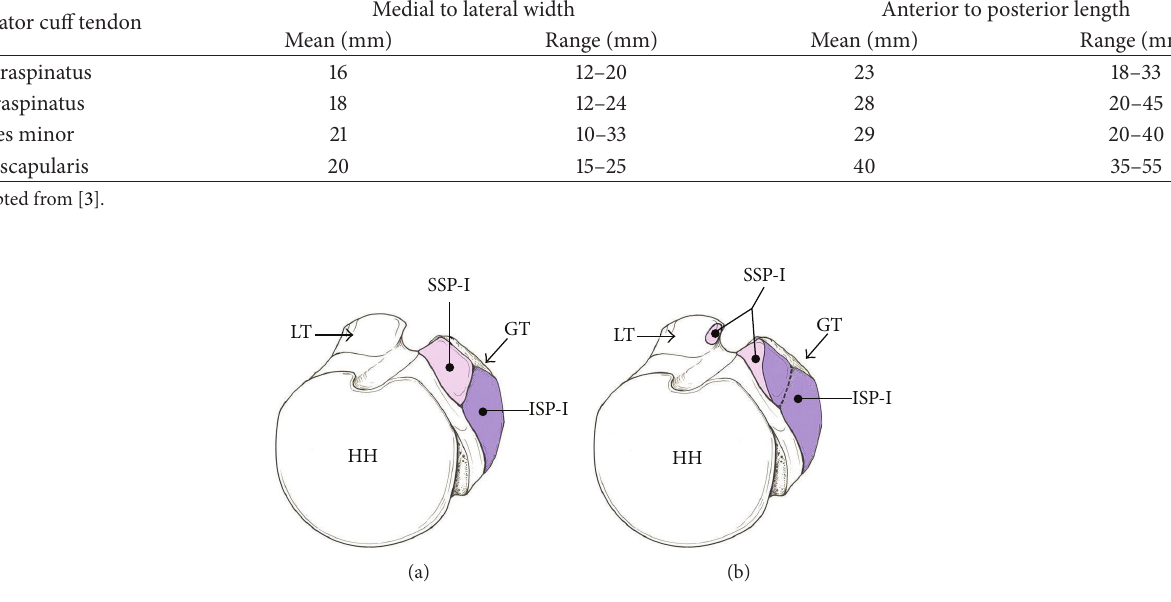
Figure 1: Illustration showing the two different insertional descriptions of the humeral insertions of the supraspinatus (SSP-I) and infraspinatus (ISP-I). (a) The generally accepted concept of the supraspinatus inserting into the highest impression and the infraspinatus inserting into the middle impression of the greater tuberosity (GT). (b) An alternative illustration, in which the insertion of the infraspinatus occupies themajority oftheGT, covering both themiddleand half of thehighest impressionof theGT. Also noted istheadditional attachment of the supraspinatus to the most superior aspect of the lesser tuberosity (LT). HH = humeral head (adapted and reprinted from [6] with